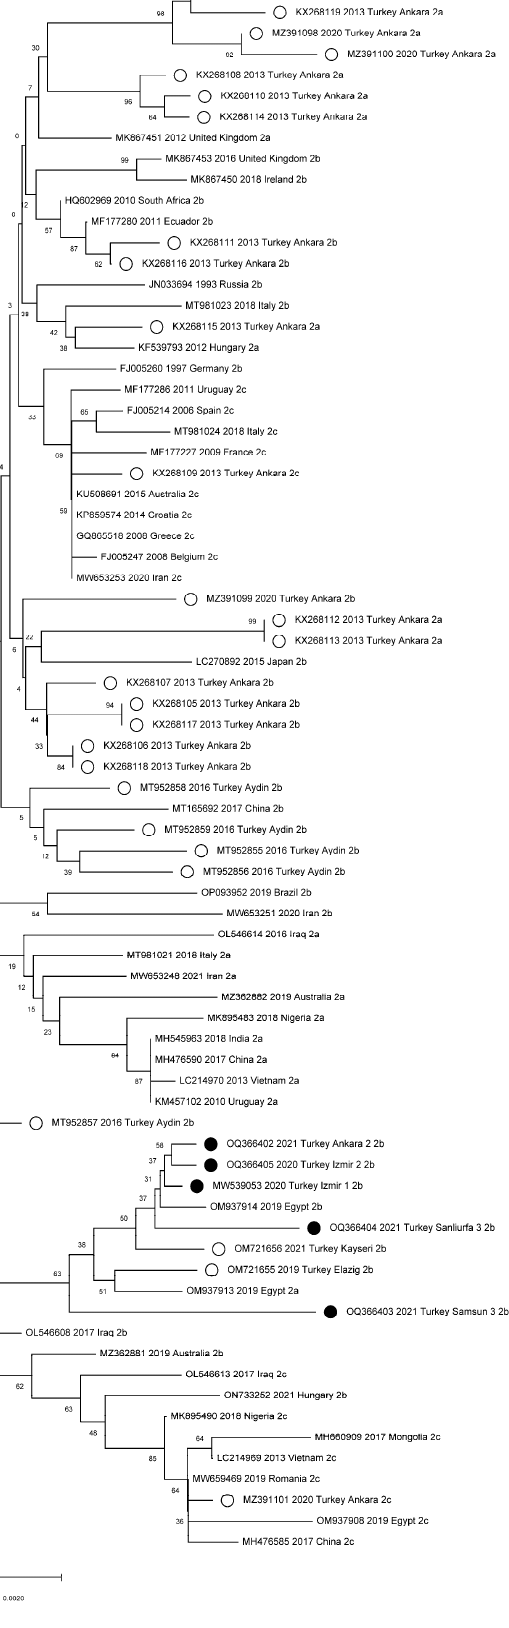
Figure 3. Phylogenetic tree based on the VP2 gene worldwide. • : Samples collected in this study from